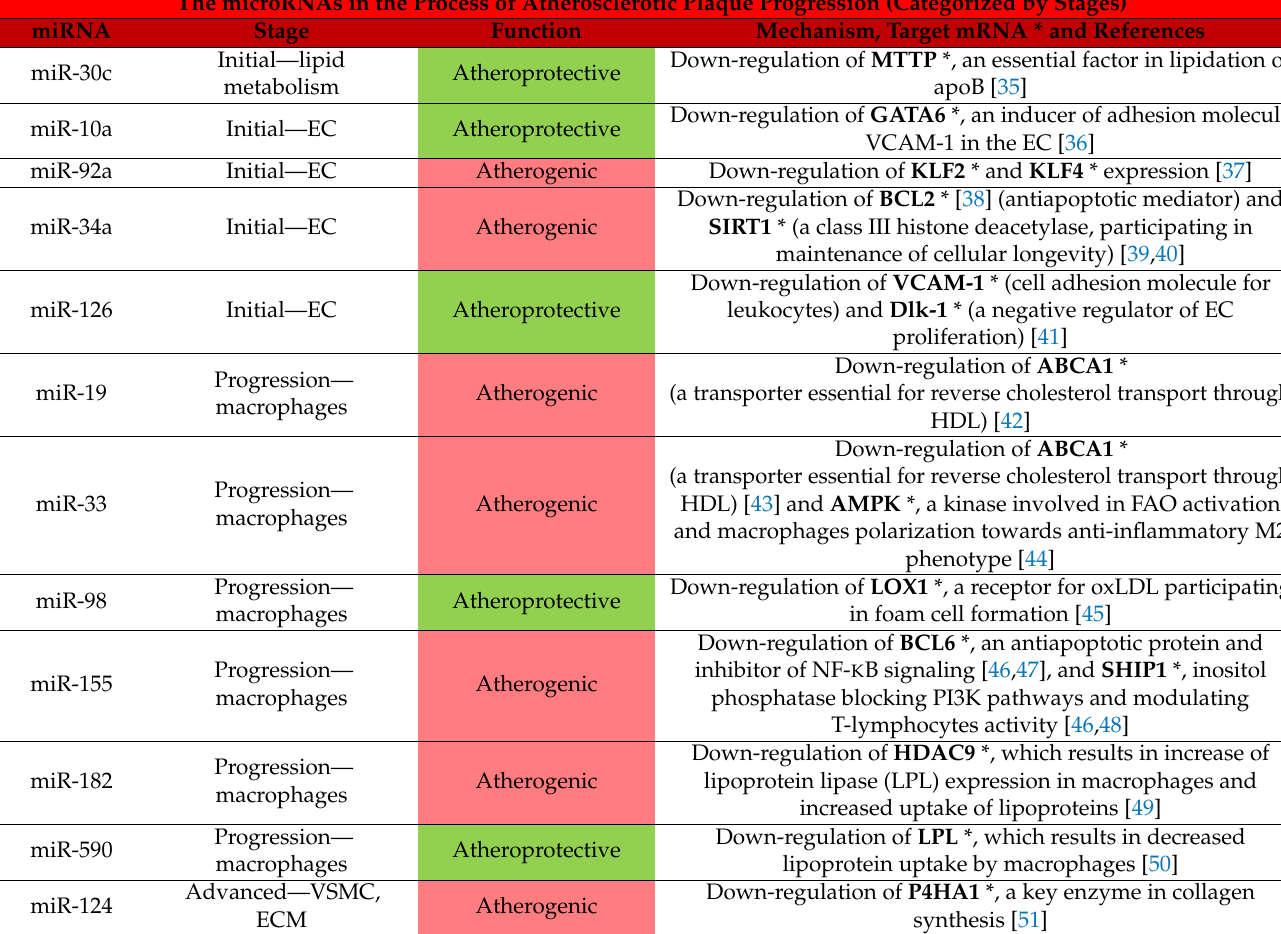
Table 2. The miRNAs and their impact upon atherogenesis. * indicates mRNAs (names in bold ) which are the targets for miRNAs and their RISC-mediated degrading activity; ** in advanced lesions, pro-atherogenic factors are also considered as factors promoting atherosclerotic plaque vulnerability. Abbreviations: EC = endothelial cells, FAO = fatty acid oxidation. 1 = a study in which ApoE − / − mice with specific knock-down of miR21 in bone-marrow cells were investigated; 2 = a study in which miR-21 knock-down Sprague Dawley (SD) rats were used; 3 = a study in which miR-24 was specifically transfected to macrophages; 4 = a study conducted on ApoE − / − mice with knockout of both miR-143 and miR-145. The microRNAs in the Process of Atherosclerotic Plaque Progression (Categorized by Stages)